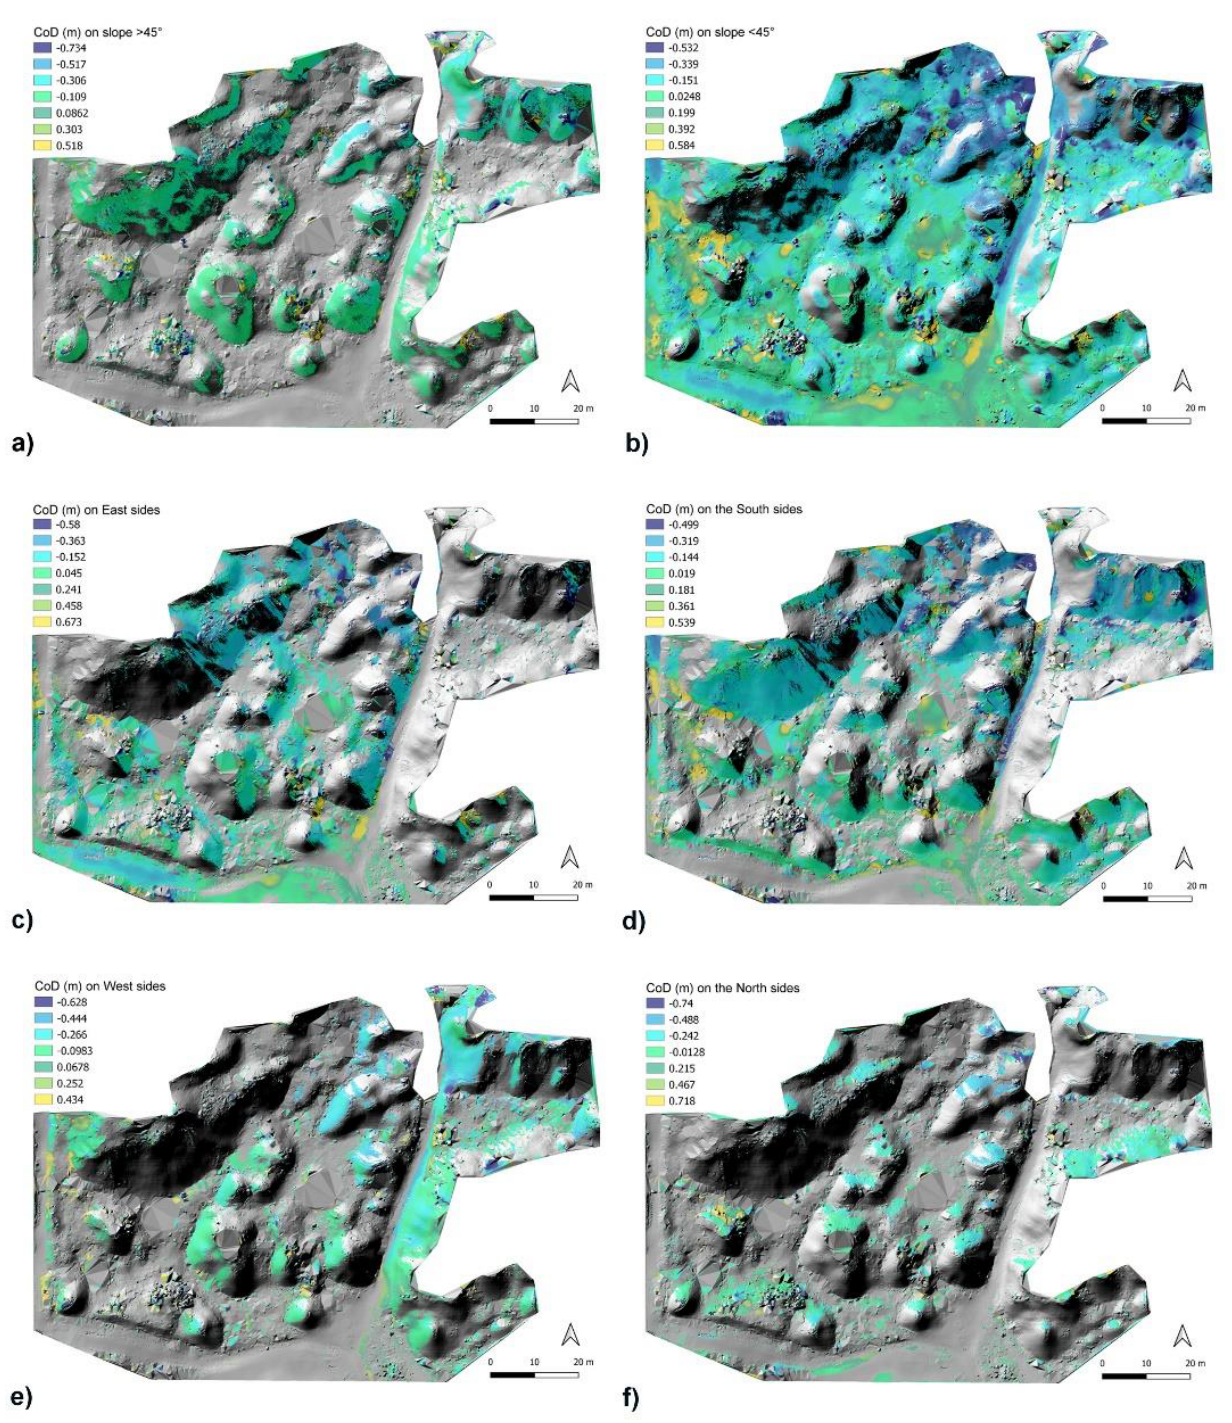
Figure 5. The CoD rasters selected according to the side slope angles: ( a ) greater than 45° and ( b ) lower than 45°; and the side exposures facing: ( c ) east, ( d ) south, ( e ) west, and ( f ) north. The CoD values are in metres. Statistical analyses aided in determining how the erosion changed on the hillslope sides. The statistical parameter distribution for each raster considered all the pixels that ranged from the maximum value of approximately 8 m to the minimum value of approx- imately − 6 m. These extreme values occurred due to noise still present in the point clouds since it was very difficult to erase all the no-terrain points (e.g., vegetation). Table 2 reports the statistical parameters of the six rasters processed according to the slope and aspect distri- butions: differences are noticeable in the ranges of the most frequent pixel values and in the quantities of these pixels, as noticeable by the % of area.